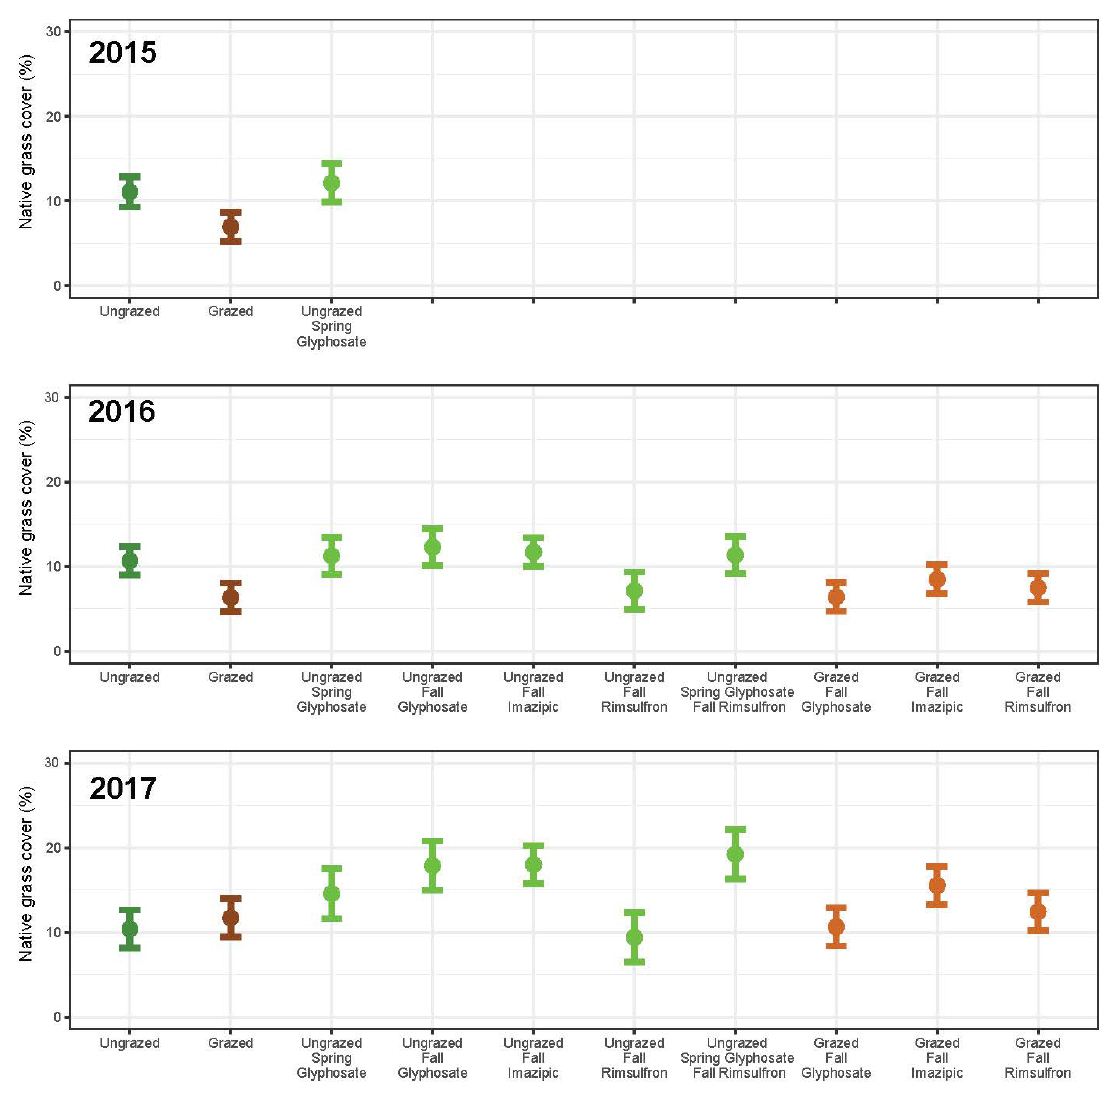
Figure 6. Fitted model results for native grass cover (%; mean ± SE) response to grazing, herbicide, and integrated treatments at Red Blu ff , Montana in 2015, 2016, and 2017. Fall herbicide treatments were implemented after summer data collection in 2015, so these treatments do not show results in 2015. Furthermore, fall herbicide results in 2016 and 2017 represent treatments implemented in the prior years. Data shown are predicted values from linear mixed e ff ects models, and thus the means are not identical to means from the raw